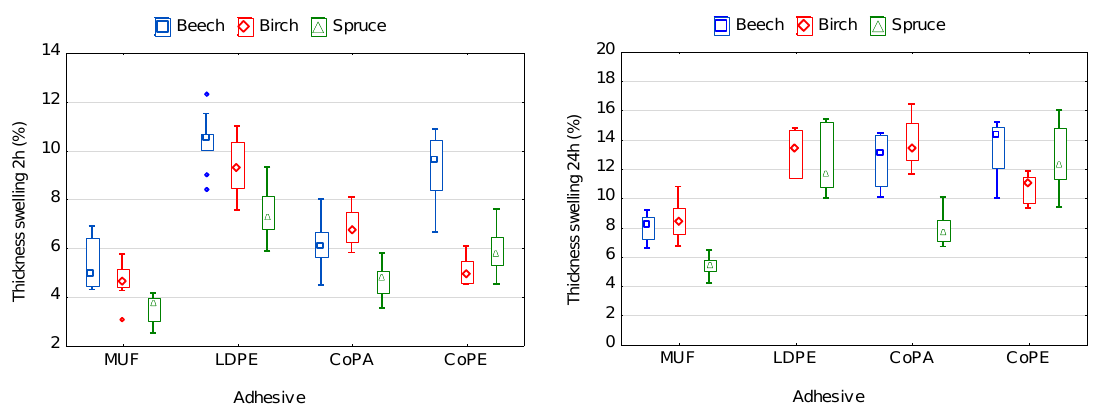
Figure 5. Thickness swelling of plywood panels bonded with different types of adhesive and using various wood species.